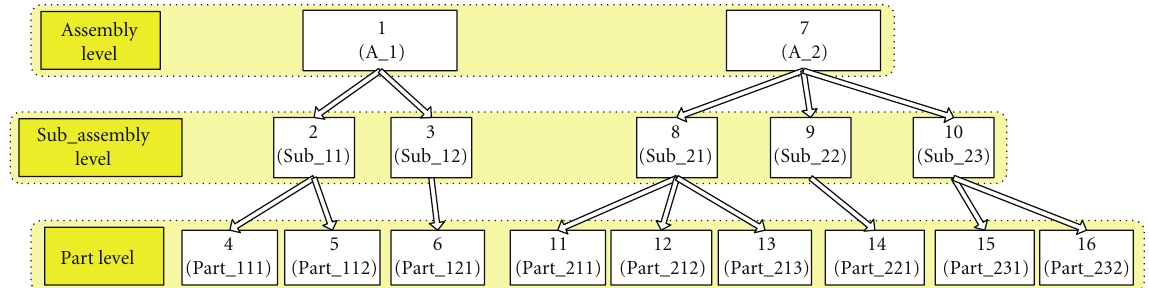
Figure 2: Example of a 3-level production scheduling problem.